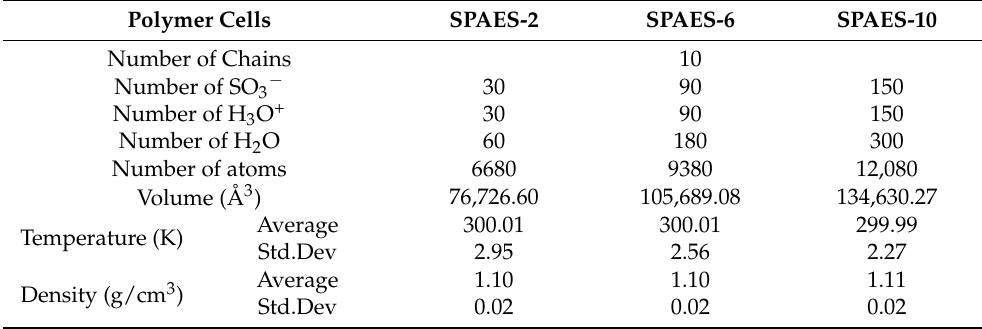
Table 1. Composition and parameters of the amorphous